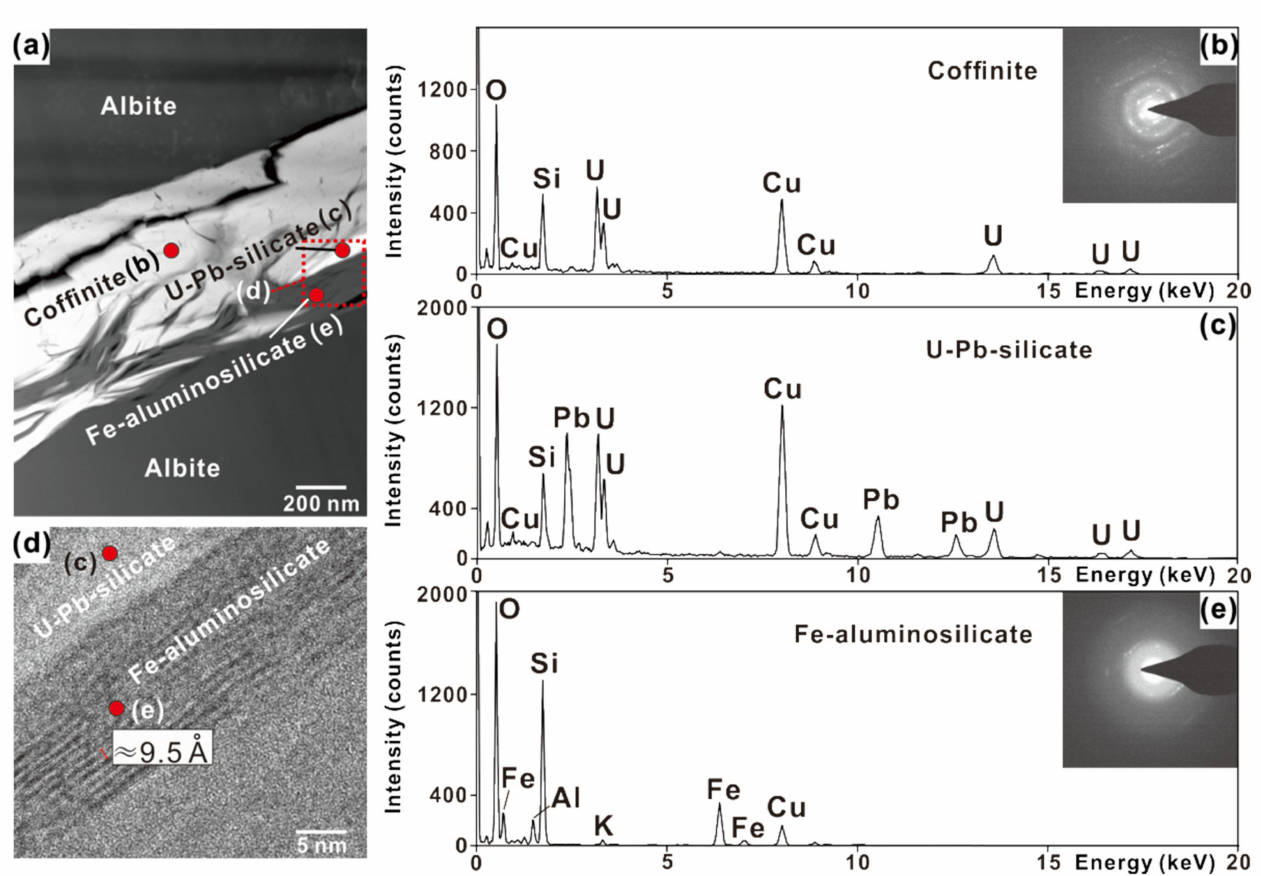
Figure 9. TEM images of Fe-U-Si-rich veinlet extending outwards from the altered uraninite in Figure 6e. ( a ) HAADF-STEM image shows that the vein is mainly composed of three phases. ( b ) SAED patterns and EDX analysis show the presence of poorly crystallized coffinite as main body of the vein. ( c ) EDX spectrum identifies needle-like U-Pb-rich silicate of part ( c ) in ( a ). ( d , e ) FFT of HRTEM image and EDX spectrum further show the border between needle-like U-Pb-rich silicate (part c) and Fe-aluminosilicate (part e) in ( a ), and that Fe-rich aluminosilicate is relatively well crystallized with approximately 9.5 Å d-spacing, which is probably indicative of clay minerals. Signal of Cu in EDX is from copper grid, rather than from the